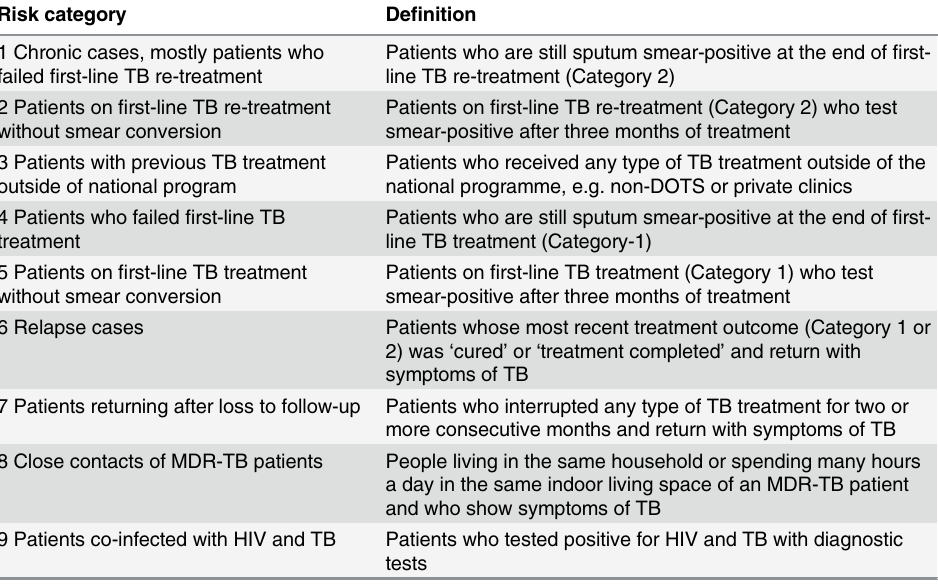
Table 1. Definitions of nine groups at risk of multidrug-resistant TB in line with Indonesian guidelines for programmatic management of drug-resistant TB.